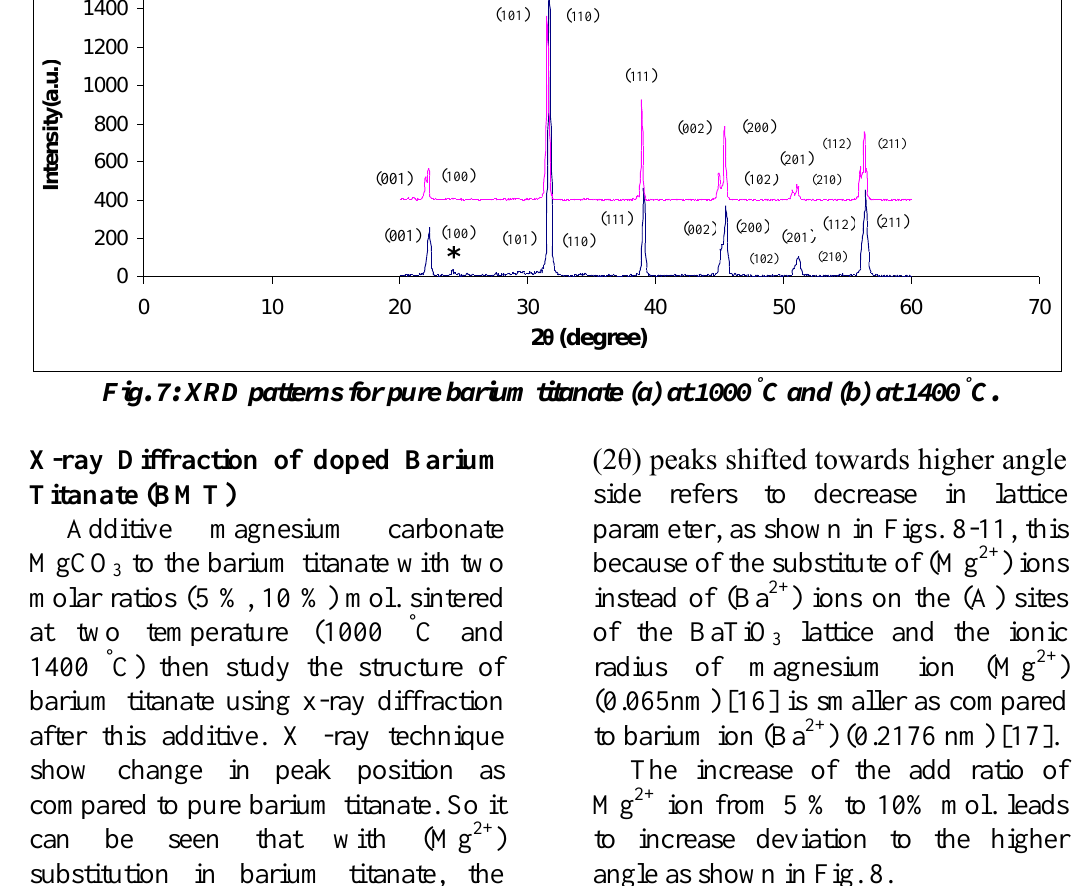
(5 %, 10 %) mol. at 1000 ° 3